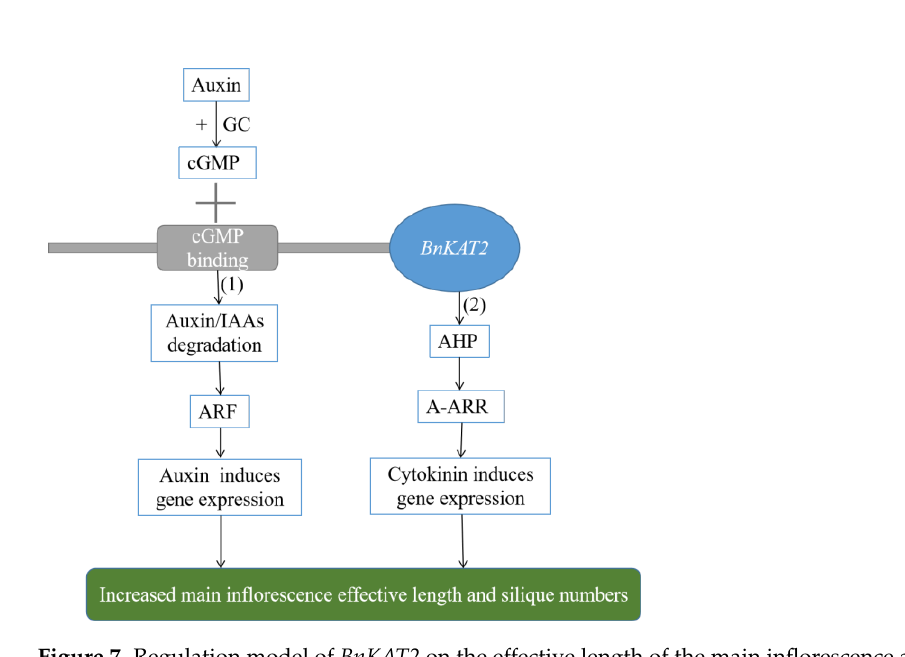
Figure 7. Regulation model of BnKAT2 on the effective length of the main inflorescence and number of siliques in B. napus. (1) BnKAT2 participates in the auxin signaling pathway by regulating the of siliques in B. napus. ( 1 ) BnKAT2 participates in the auxin signaling pathway by regulating the expression of Aux/IAA by cGMP. (2) BnKAT2 participates in the auxin signaling pathway by regu- expression of Aux/IAA by cGMP. ( 2 ) BnKAT2 participates in the auxin signaling pathway by regulating lating the expression of AHP and ARR genes. the expression of AHP and ARR